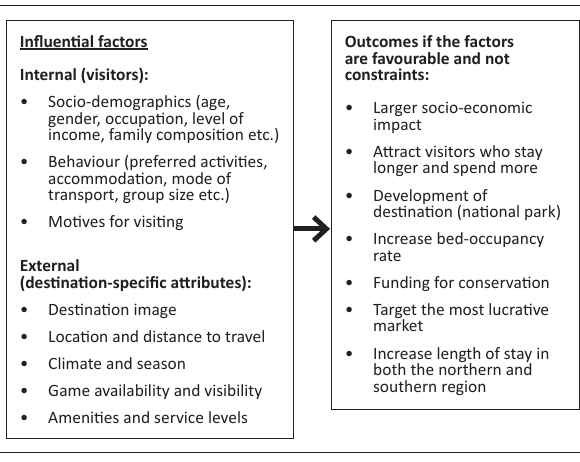
FIGURE 2: Factors influencing visitors’ length of stay at a destination (national